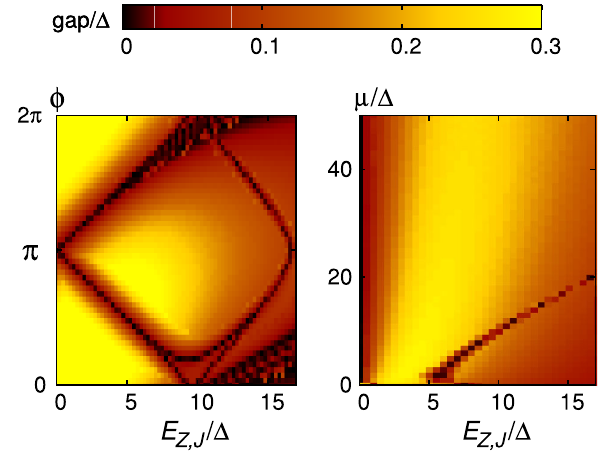
FIG. 8. Inducedgapasa functionofsystem parametersevaluated in the continuum model using the scattering matrix approach (see Appendix D 1 for details) for W ¼ 1 ð m Δ Þ − 1 = 2 , m α 2 ¼ 9 Δ , and 0 . In the left panel, μ = Δ ¼ 20 . The diamond-shaped gap E Z;L ¼ closing lines indicate the boundary between the trivial and the topological regions. Additional regions of small gap occur in the vicinity of BDI phase transitions, where the gap closes at nonzero momenta. In the right panel, ϕ ¼ π , and a sizable topologicalgap is obtained in a very broad range of Zeeman fields with hardly any dependence on the chemical potential.